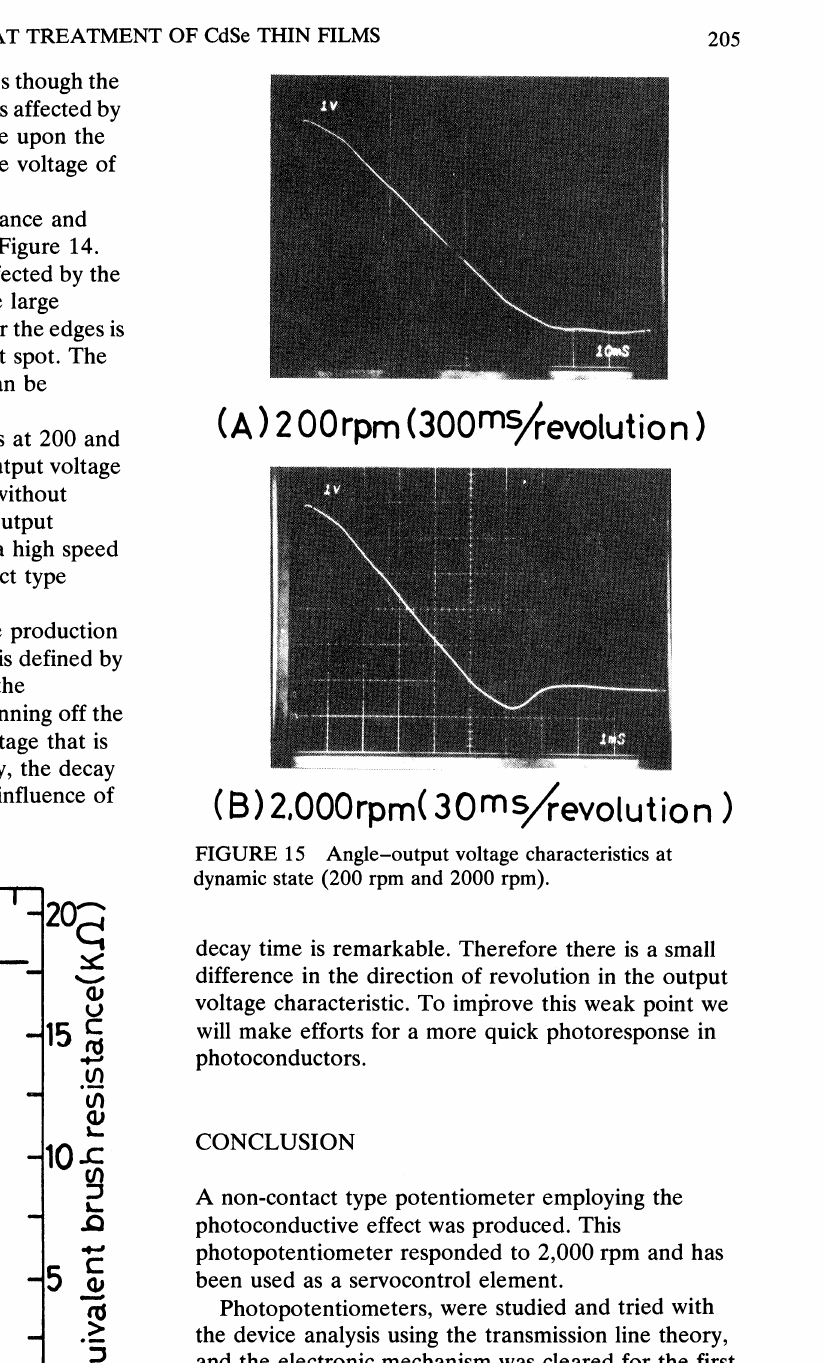
FIGURE 14 Angle-input resistance Ri(S)and equivalent brush resistance Rp(S) characteristics at static state.